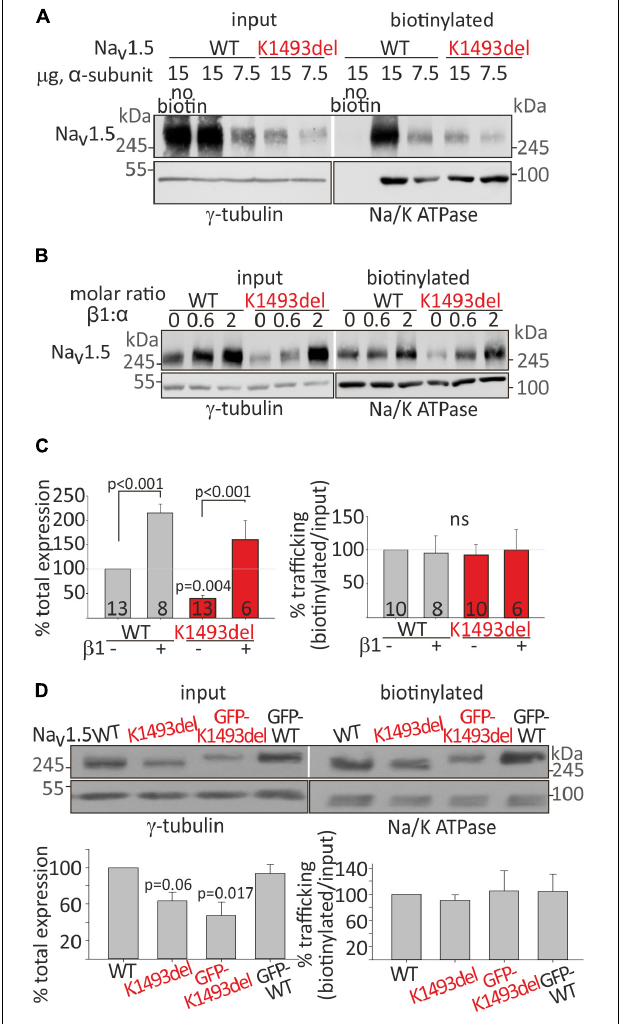
FIGURE 3 | Cell surface and total expression of Na V 1.5 WT and Na V 1.5 K1493del . (A,B) Representative biotinylation assays. (A) HEK cells were transfected with Na V 1.5 WT and Na V 1.5 K1493del . The control “no-biotin” group shows no signal from non-biotinylated channels. (B) HEK cells transfected with Na V 1.5 WT and Na V 1.5 K1493del (7.5 µ g) +/– rNa V β 1 (2.5 and 7.5 µ g). (C) Summary of % total protein (left) and % trafficking (right), normalized to Na V 1.5 WT without Na V β 1. N = 9 experiments without Na V β . N = 4 experiments with rNa V β 1 expressed. Groups expressing rNa V β 1 in molar ratios β : α 0.6-2 were pulled together. (D) GFP-fused and non-tagged Na V 1.5 WT and Na V 1.5 K1493del were expressed (without Na V β subunit). This is a summary of three experiments. Statistical significance was determined